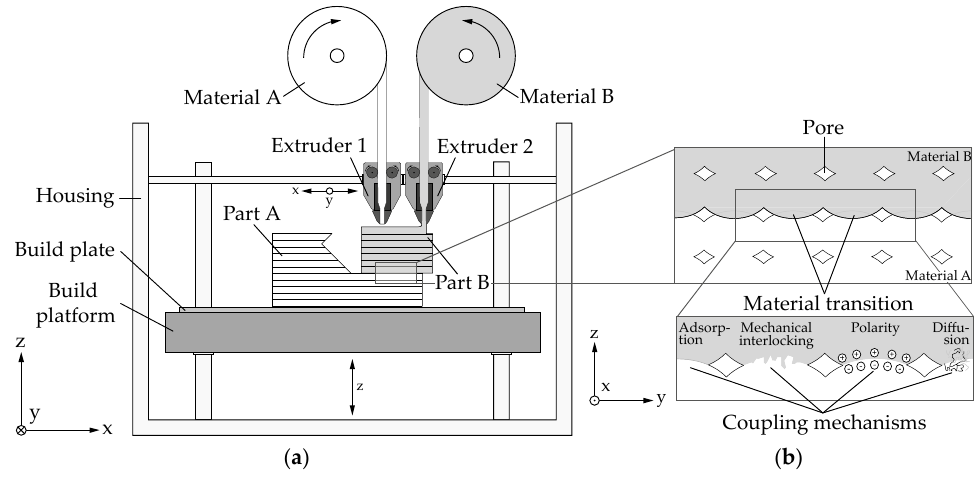
Figure 1. ( a ) Schematic representation of material extrusion (ME) principle and ( b ) material transition including relevant coupling mechanisms.